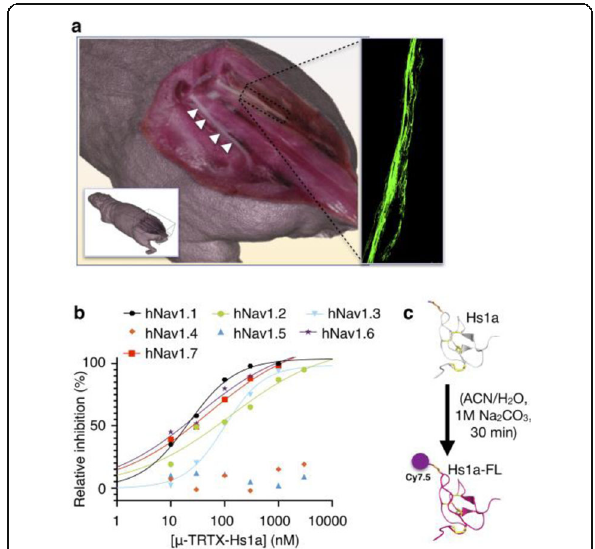
Fig. 1 Ion channel selectivity and chemical synthesis of Hs1a-FL. a Representative view of the experimental settings. A 3D rendering of a frozen and sliced mouse. White arrows show the left sciatic nerve. Right sciatic nerve magnification shows the fluorescent Hs1a-FL agent bound to the nerve surface. b Selectivity of Hs1a towards human Na V channels stably expressed in HEK293 cells. Calculated IC 50 values were hNa V 1.1; 19.4 nM, hNa V 1.2; 81.2 nM, hNa V 1.3; 106.8 nM, hNa V 1.4; > 3000 nM, hNa V 1.5; > 3000 nM, hNa V 1.6; 19.2 nM, hNa V 1.7; 26.9 nM. Each point on the curve is an average of 3 – 11 cells. c Reaction scheme for conjugation of Hs1a peptide with Cyanine7.5-NHS ester dye. The ribbon model of Hs1a-FL shows disulfide bridges (in yellow) and shows the attachment of one dye to the peptide